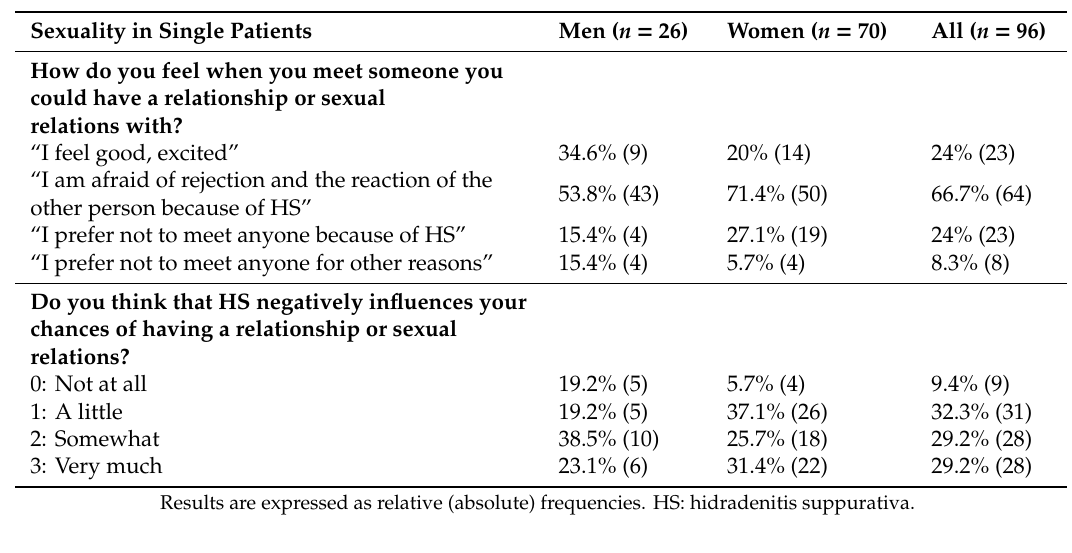
Table 5. Sexuality in single patients with